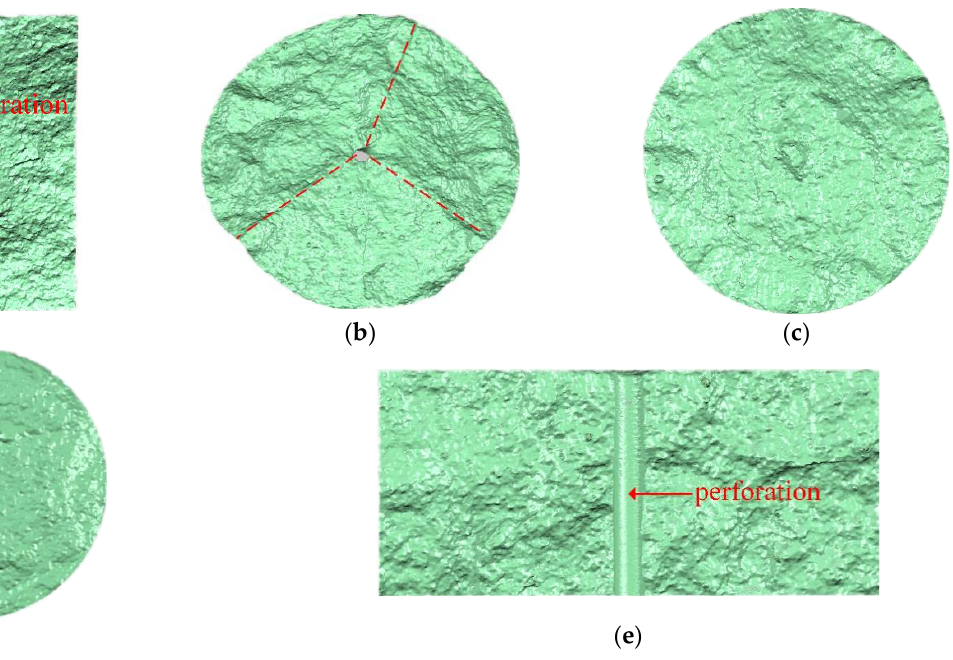
Figure 10. The morphologies of typical fracture surfaces: ( a ) longitudinal fracture in specimen A1; ( b ) oblique fractures in specimen B1; ( c ) transverse fracture in specimen C3-1; ( d ) transverse fracture in specimen D2-1; ( e ) longitudinal fracture in D2-1. Table 5. The Area Ratio (AR) of the main fracture surfaces. Group Specimen